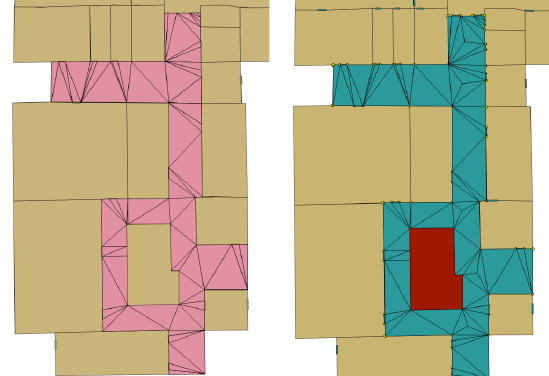
Figure 5. CDT & subspacing facets with no constrained